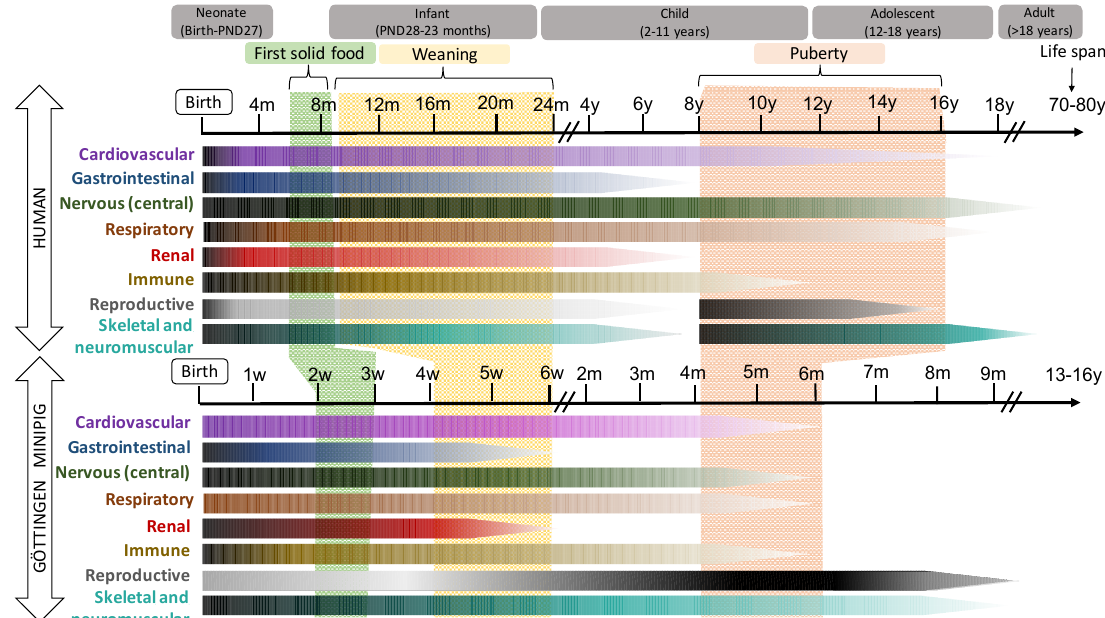
Figure 1. Schematic representation of the postnatal development of different organ systems in human (top) and Göttingen Minipig. In the horizontal bars, the intensity of the maturation process is represented by dark (more intense) and light (less intense) tones. The time bar represents weeks (w), months (m) or year (y) of life.